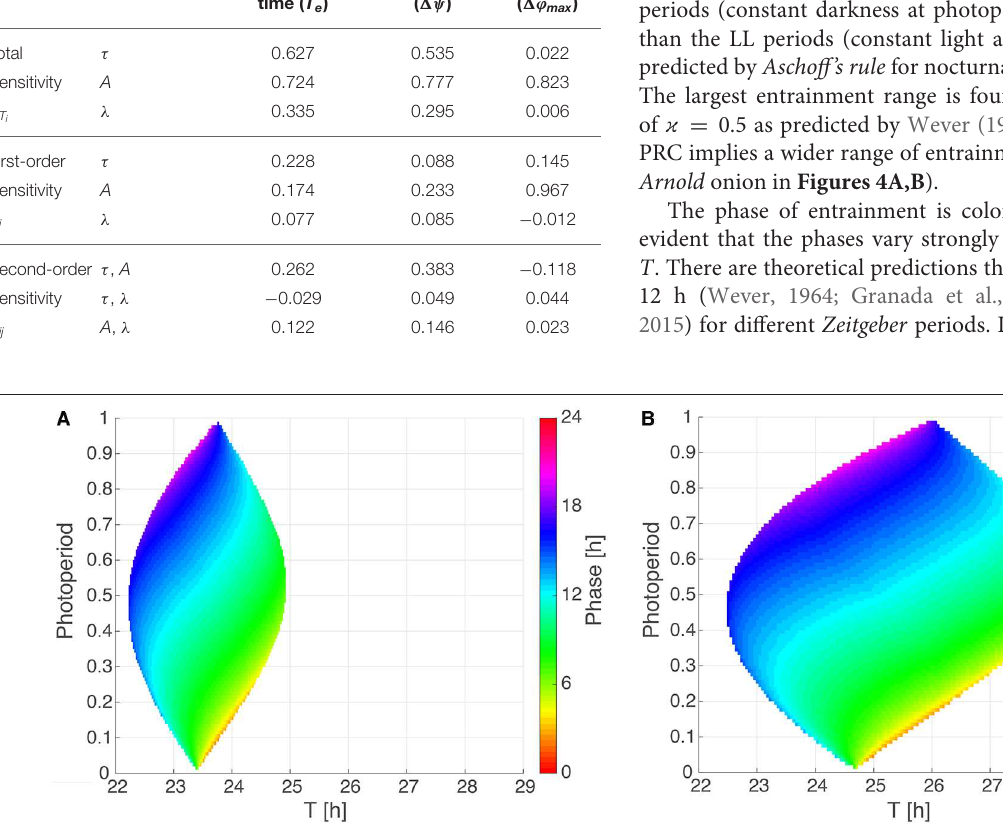
FIGURE 4 | Arnold onions for the two PRC constraints. (A,B) 1:1 entrainment ranges in the ̹ - T parameter plane ( Arnold onions). Entrainment phases were determined by numerical simulations and have been color-coded within the region of entrainment. Panel (A) depicts an Arnold onion for an optimized parameter set with a ± 1 h PRC, a short-period τ = 23.36 h, A = 2.063, and λ = 0.386 h − 1 . Panel (B) shows an Arnold onion for an optimized parameter set with a ± 2 h PRC, a long–period τ = 24.64 h, A = 1.144, λ = 0.50 h − 1 .